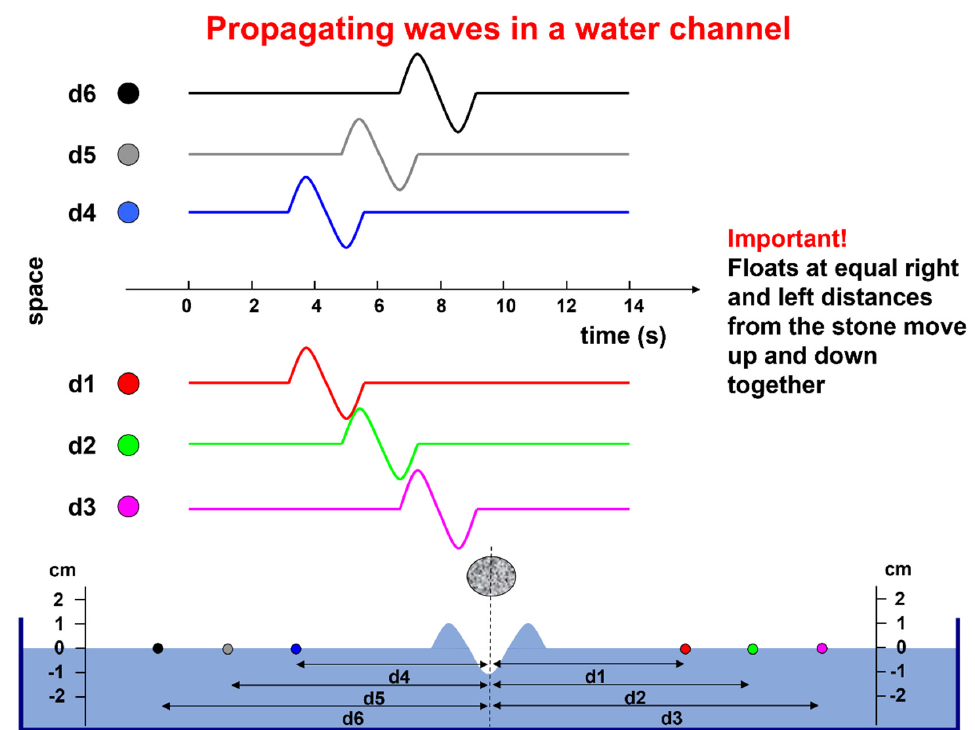
Figure 4. Example of a bidirectional wave generated by dropping a stone in a narrow water channel (representing a single fiber). The floats represent a series of electrodes detecting the wave in subse- quent times and in two directions. One pair of floats at equal distances from the stone detect identical waves and their difference is zero. Knowing the distance between floats and the delay between the waves they detect allows for the estimation of the wave propagation velocity. (See animation in Supplementary Materials, Sup2). Courtesy of Dr. Alberto Botter.